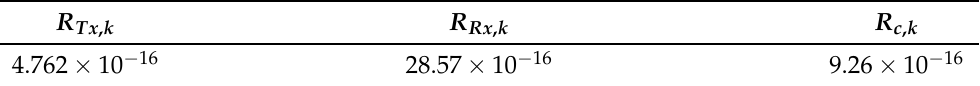
associated with the system. C , k + 1